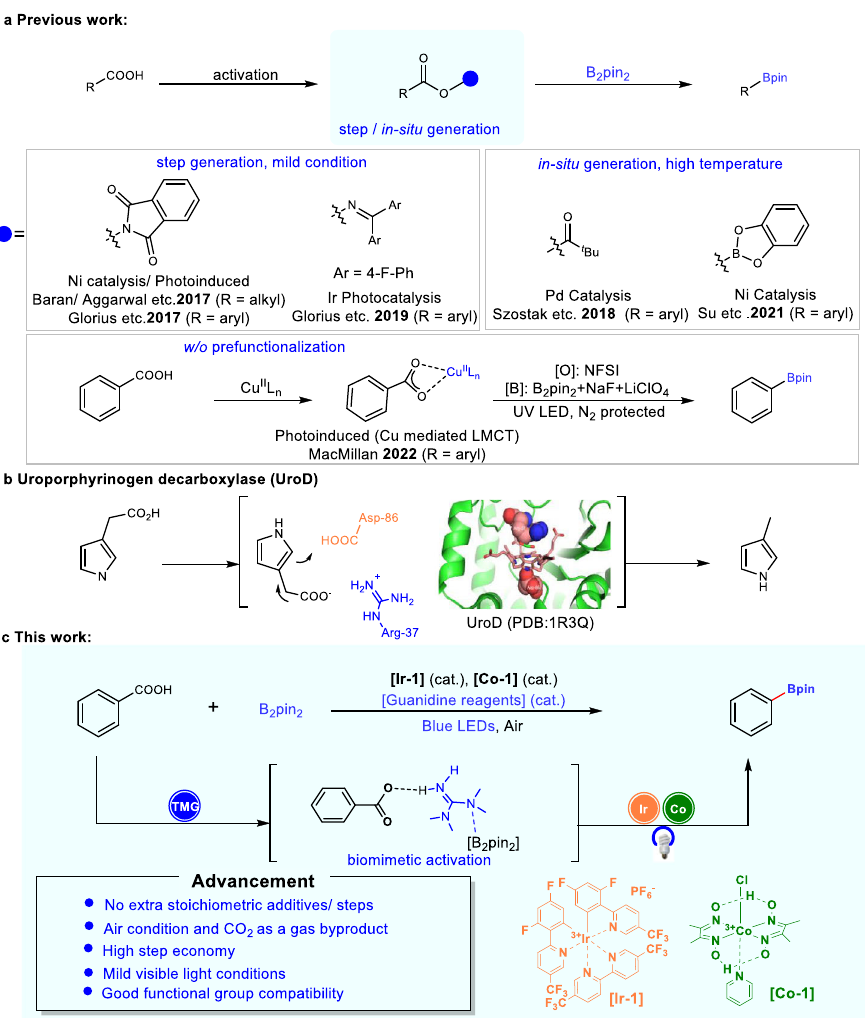
Fig. 1 | Introduction. a Previous reported decarboxylative borylation. b Mechanism of Uroporphyrinogen decarboxylase (UroD). c This work on the direct borylation. Cat.,